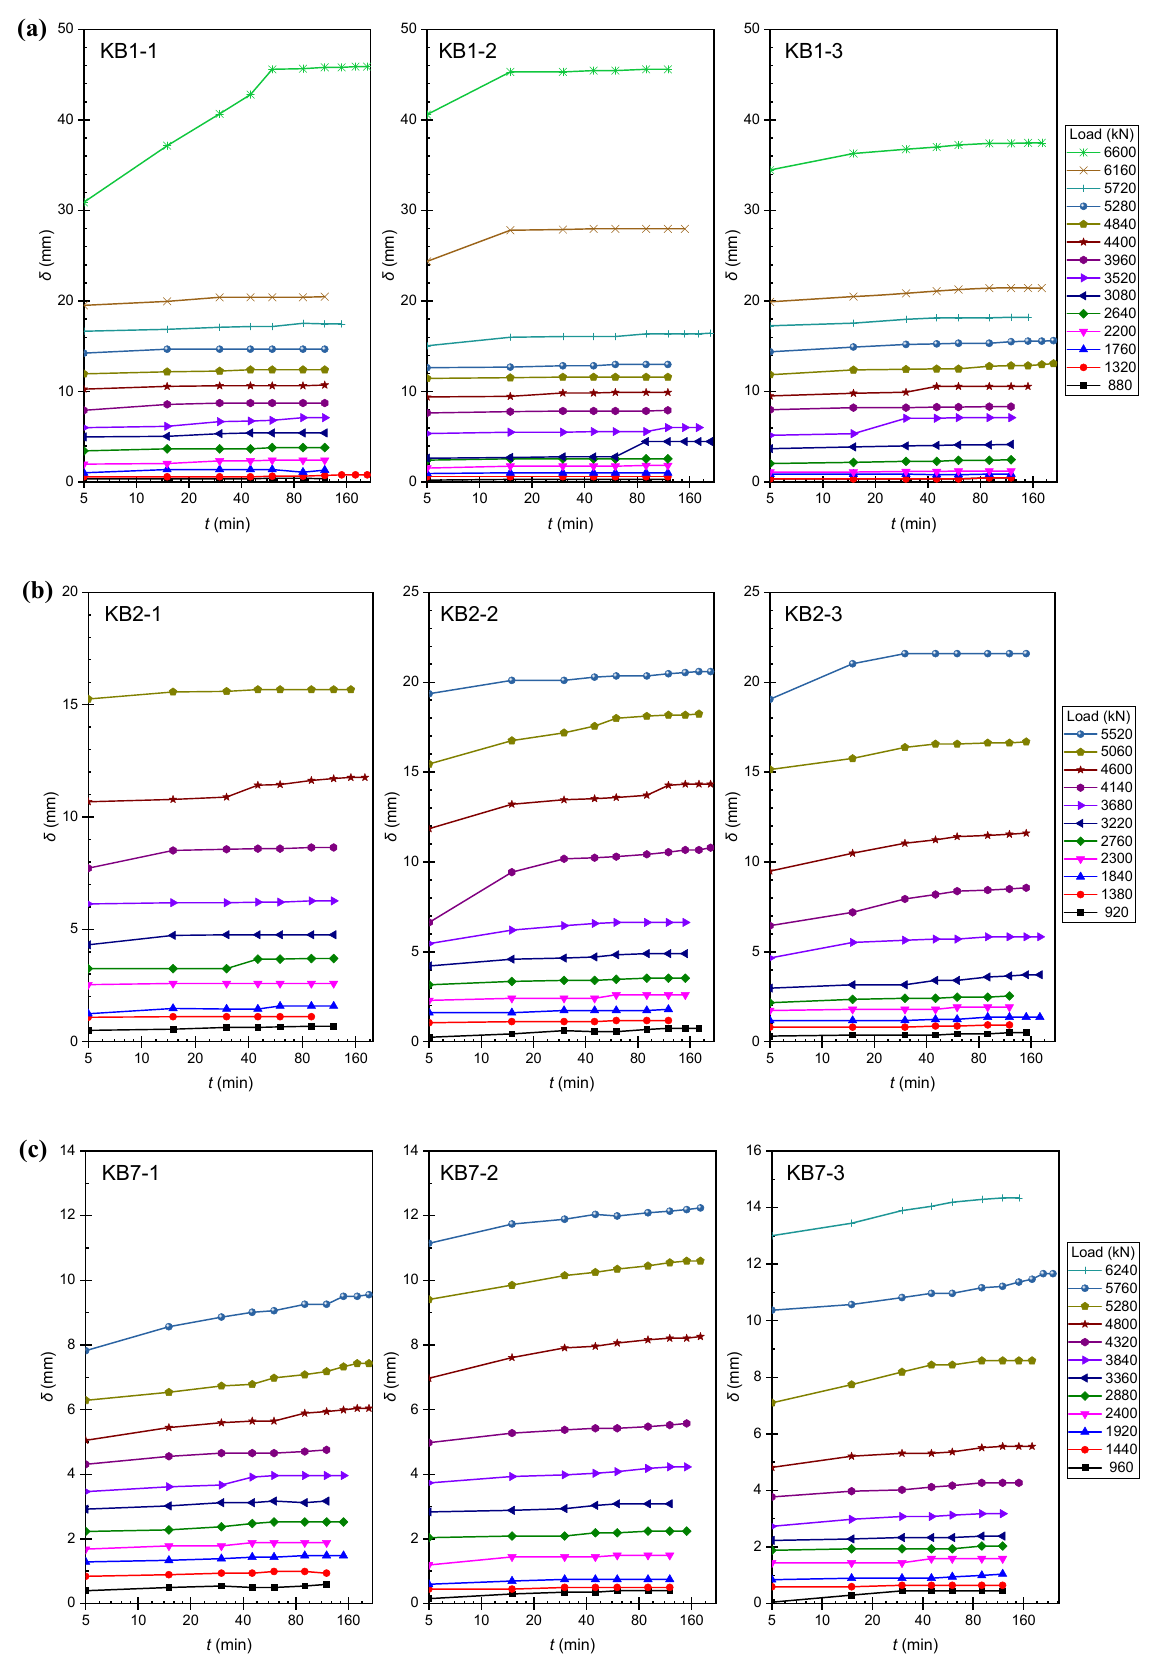
Figure 5. Experimental curves of δ - lg t for test piles: ( a ) KB1; ( b ) KB2; ( c )